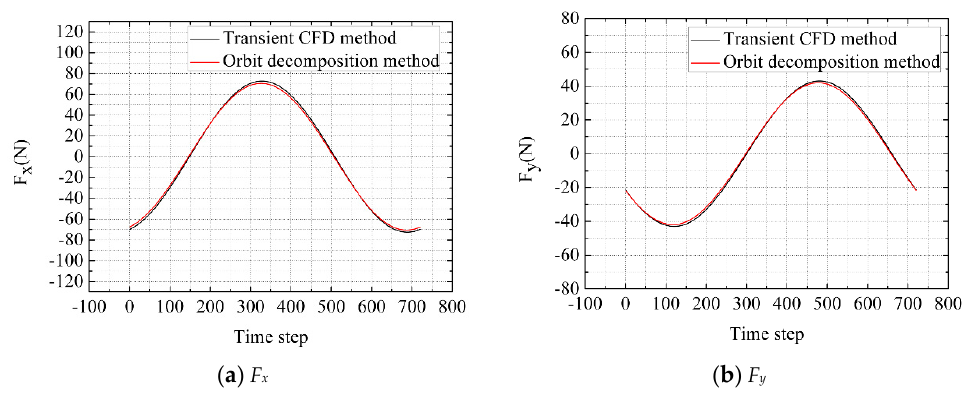
Figure 12. Comparison of fluid-induced forces at f = 30 Hz.